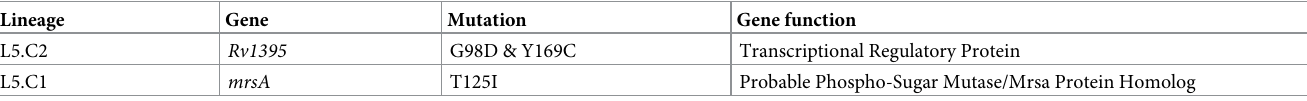
Table 4. Genomic analysis for urease activity